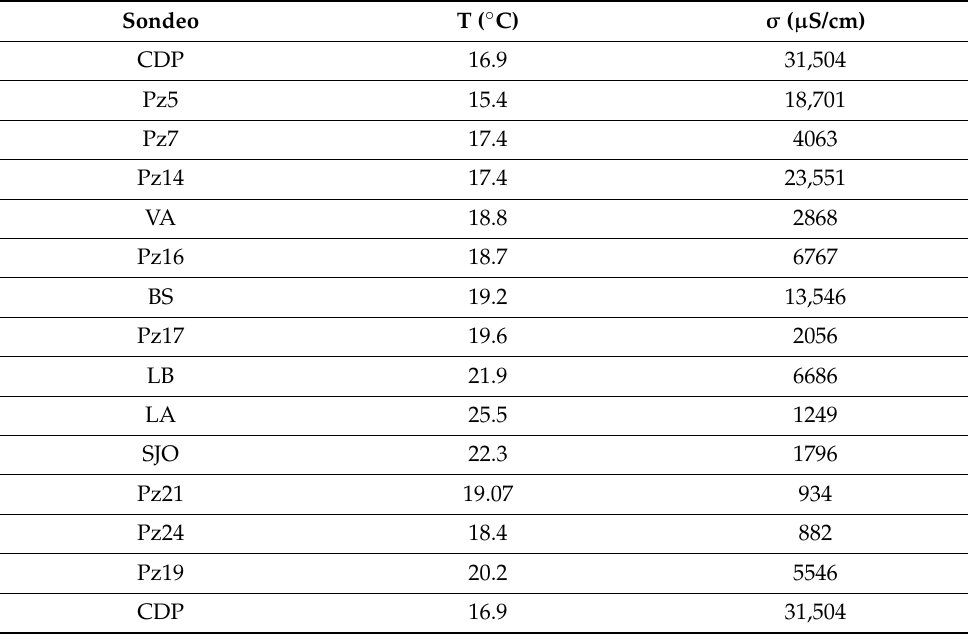
Table 1. Temperature and conductivity values were logged in the month of